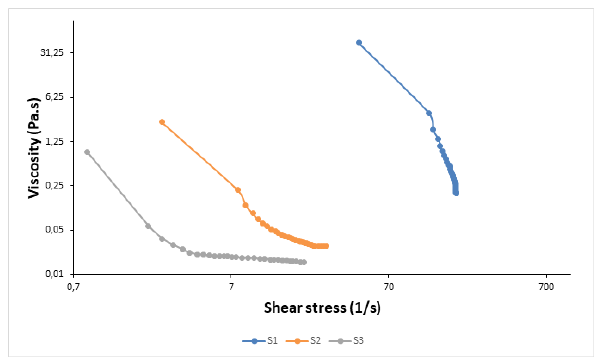
Figure 3: Viscosity versus shear stress (log-log scale) (sample S1: untreated phosphate dust, sample S2: calcium phosphate dust from the outside of filter and sample S3: calcium phosphate dust from the inside of filter)